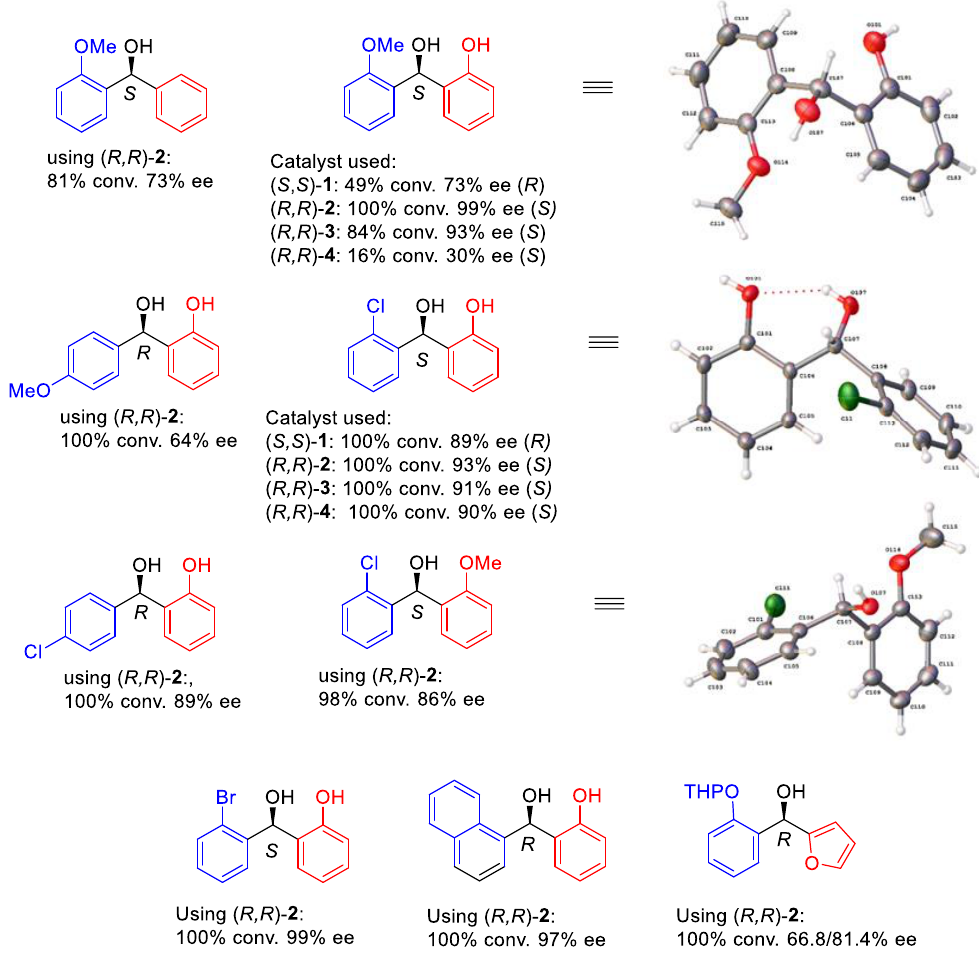
Figure 10. Further examples of ATH of ortho -hydroxy benzophenones.